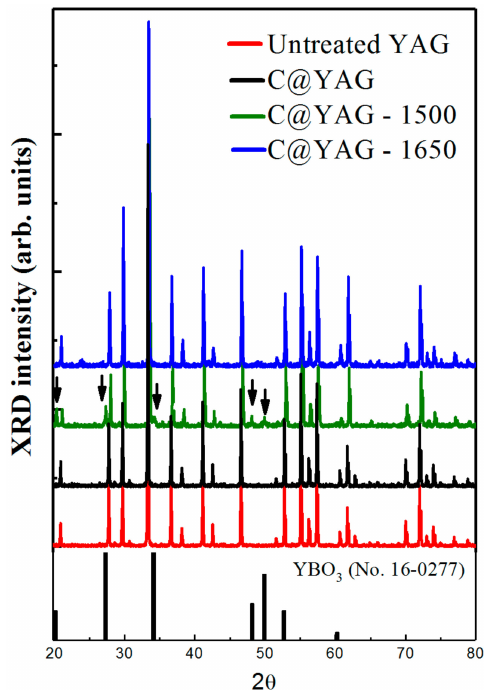
Figure 1. X-ray diffraction (XRD) patterns for untreated YAG:Ce 3+ , C@YAG:Ce 3+ ,C@YAG:Ce 3+ - 1500 ◦ C and C@YAG:Ce 3+ -1650 ◦ C. The arrows indicate the additional peaks ascribed to secondary